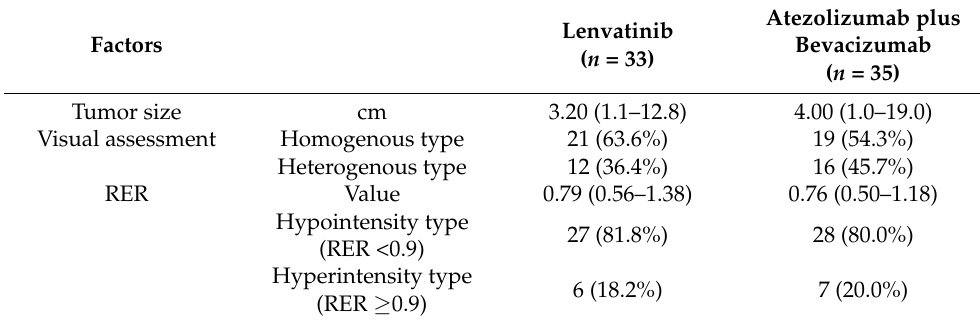
Table 2. Image analysis by EOB-MRI hepatobiliary